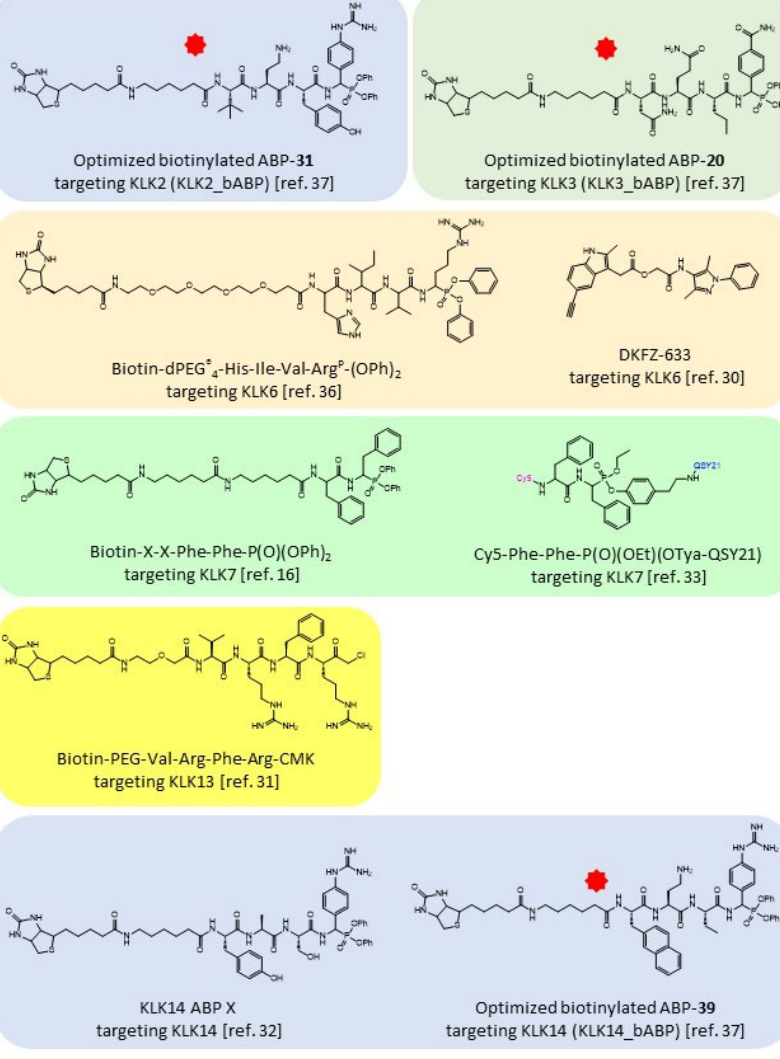
Figure 6. Chemical structures of ABPs targeting active KLKs. The chemical formulas of all reported ABPs that bind to KLKs are shown. Red stars indicate that analogues of these molecules labelled with fluorescent moieties have been generated.